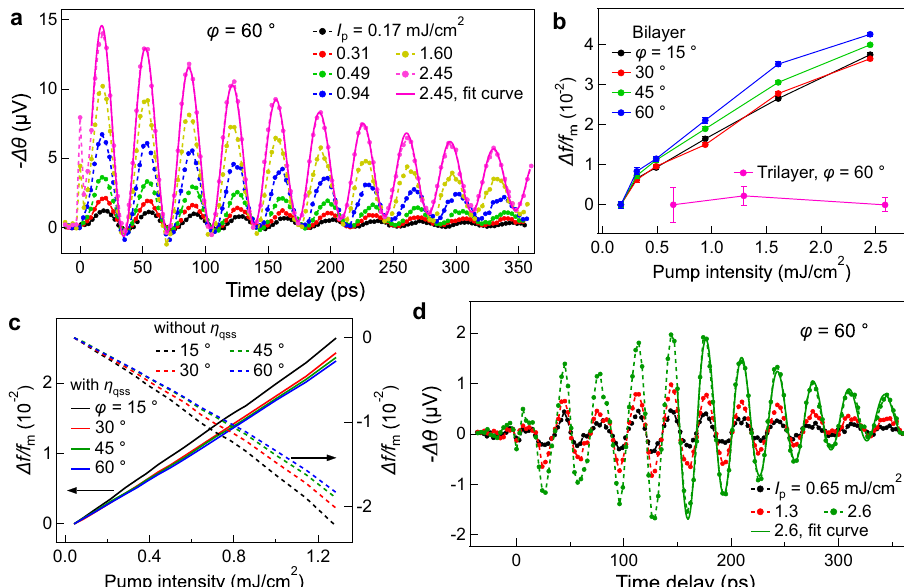
Fig. 2 Spin precession as a function of the pump intensity of the Co bilayer. a Differential magneto-optical Kerr rotations Δ θ ( t ) of the Co(25) bilayer as a function of pump intensity I p under the magnetic fi eld H ext = 0.4 T and φ = 60° ( φ : the magnetic fi eld angle from out-of-plane direction). b Summary of the frequency change of the spin precession Δ f/f m for the bilayer as a function of I p and φ (15°: black, 30°: red, 45°: green, 60°: blue circles). Here f m is de fi ned as the precession frequency for the minimum I p . The pink circles present Δ f/f m obtained from the Co(25) in the trilayer. All data points are presented with error bars obtained from the least-square fi t. c Model calculation results of Δ f/f m based on the Landau-Lifshitz-Gilbert (LLG) equation for the presence (solid lines) and absence (dashed lines) of η qss , respectively. d Δ θ ( t ) induced by η p for the trilayer under H ext = 0.4 T and φ =